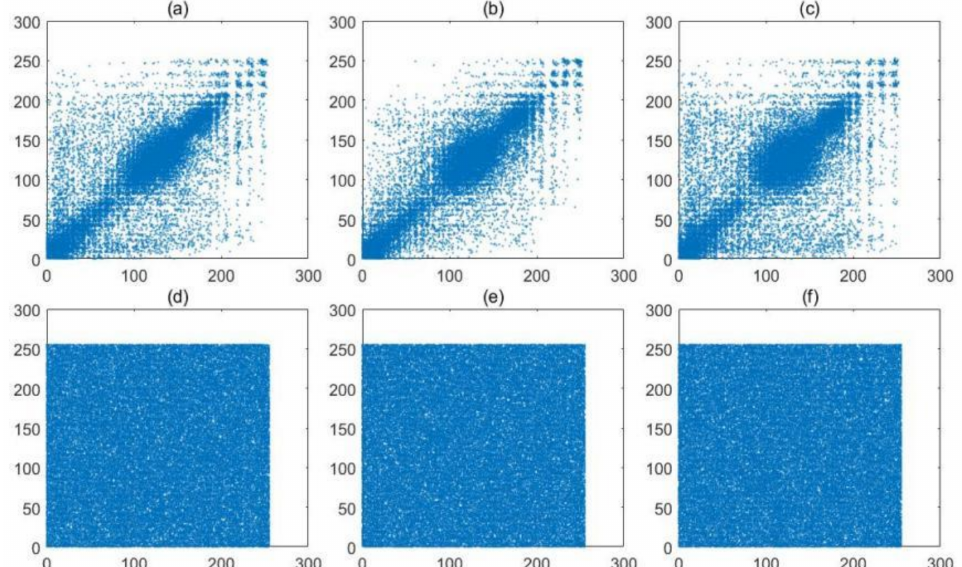
Figure 18. Correlation analysis of Cameraman image: ( a ) Adjacent pixel points of the plain-text image in horizontal direction; ( b ) Adjacent pixel points of the plain-text image in vertical direction; ( c ) Adjacent pixel points of the plain-text image in diagonal direction; ( d ) Adjacent pixel points of the encrypted image in horizontal direction; ( e ) Adjacent pixel points of the encrypted image in vertical direction; ( f ) Adjacent pixel points of the encrypted image in diagonal